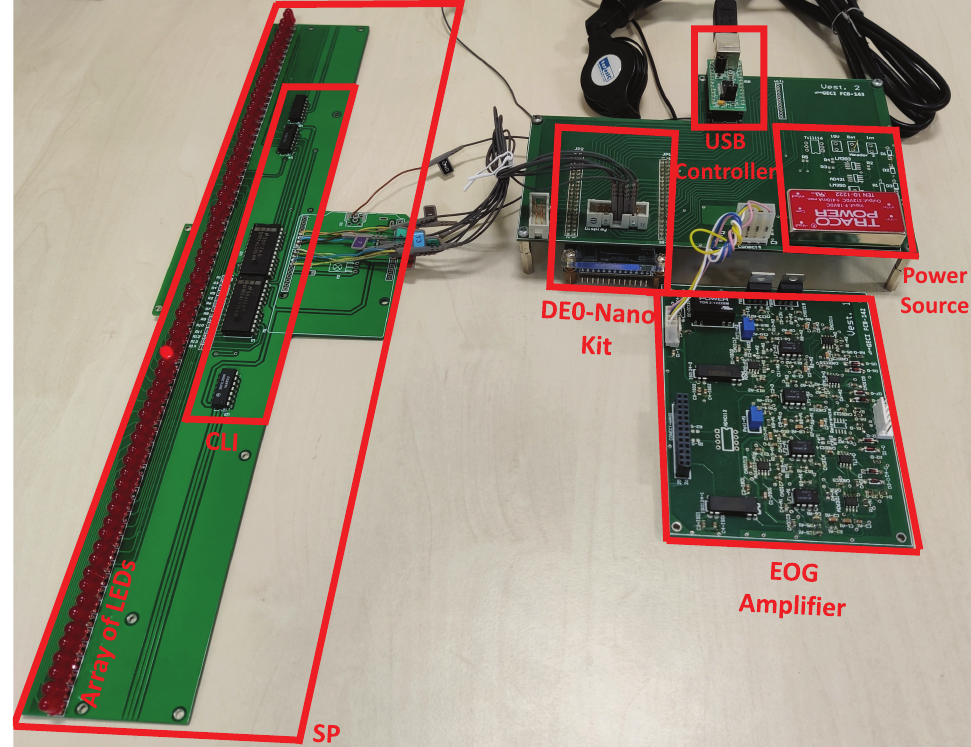
Figure 16. Experimental setup. The principal components are labelled. Only the central part of the array of LEDs is shown. The electrodes for the EOG signal acquisition are not